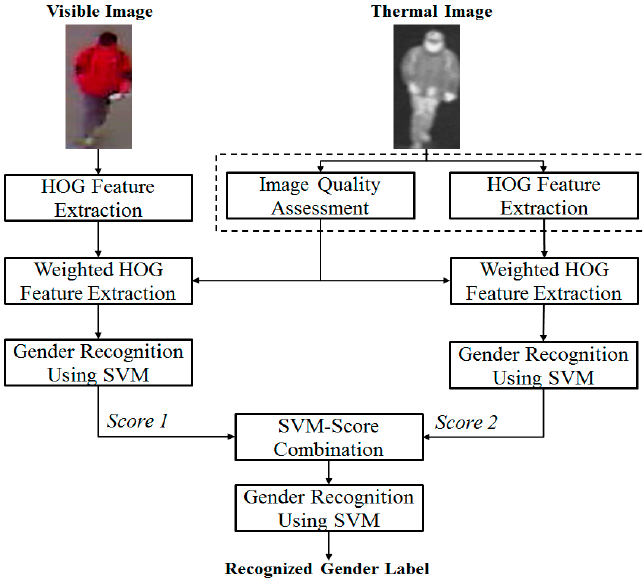
Figure 1. Overall procedure of our proposed method for gender recognition using visible light and thermal images, including image quality assessment.